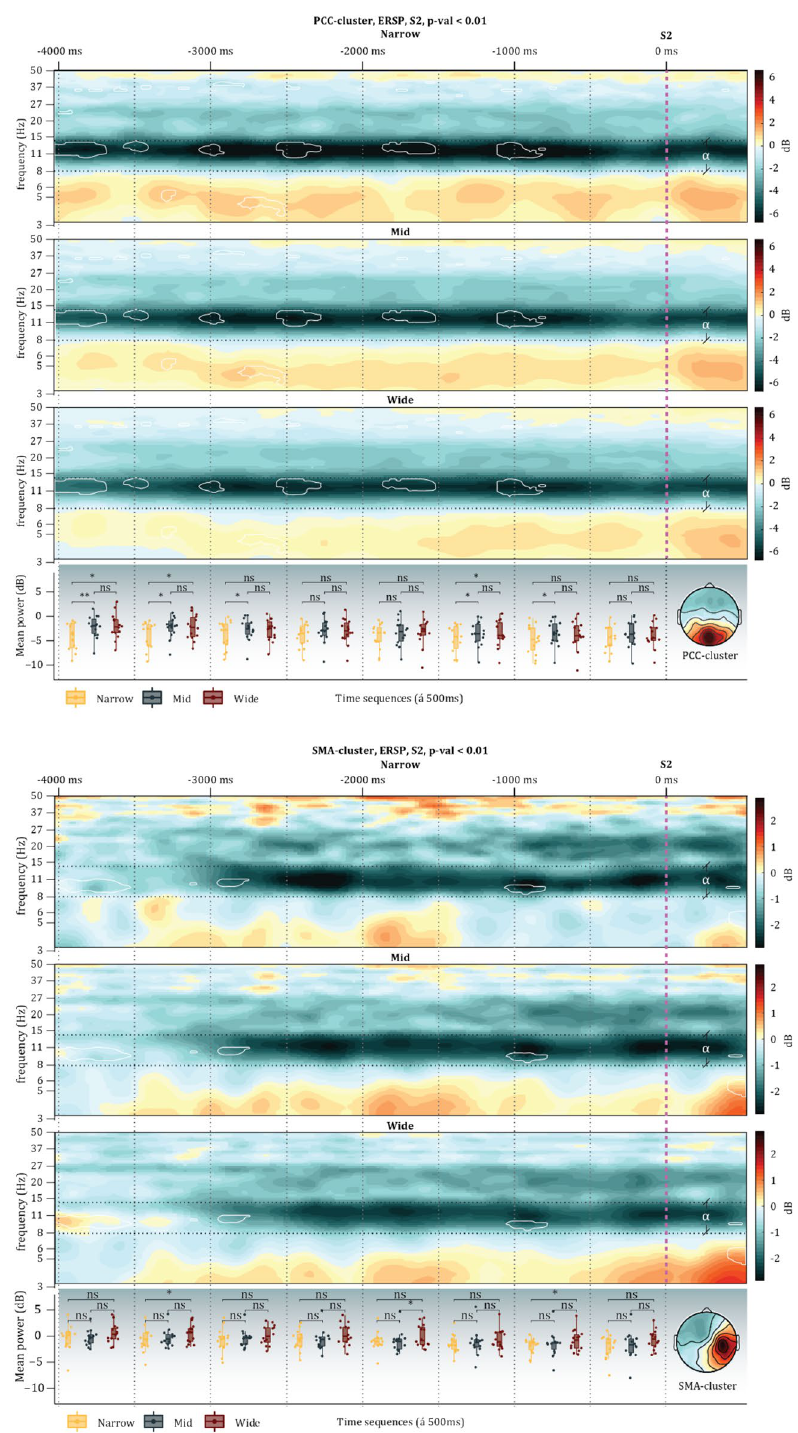
Figure 7. The panel above displays the ERSPs for each condition in the PCC-cluster (above) and the SMA- cluster (below) during the mobile phase. The overlayed white lines represent the areas with a significant difference according to the permutation tests (1,000 permutations). The vertical magenta dashed line represents the moment they passed through the transition (Threshold), while the vertical dotted black lines represent the time sequence (500 ms per sequence) that alpha power values were separated into and analysed by way of ANOVA and Tukey HSD. Horizontal black dashed lines represent the range of the alpha frequency. The bottom panel illustrates the Tukey HSD results; all p > .05 are written as ‘ns’, all p < .05 are written *, all p < .01 are written **, and all p < .001 are written